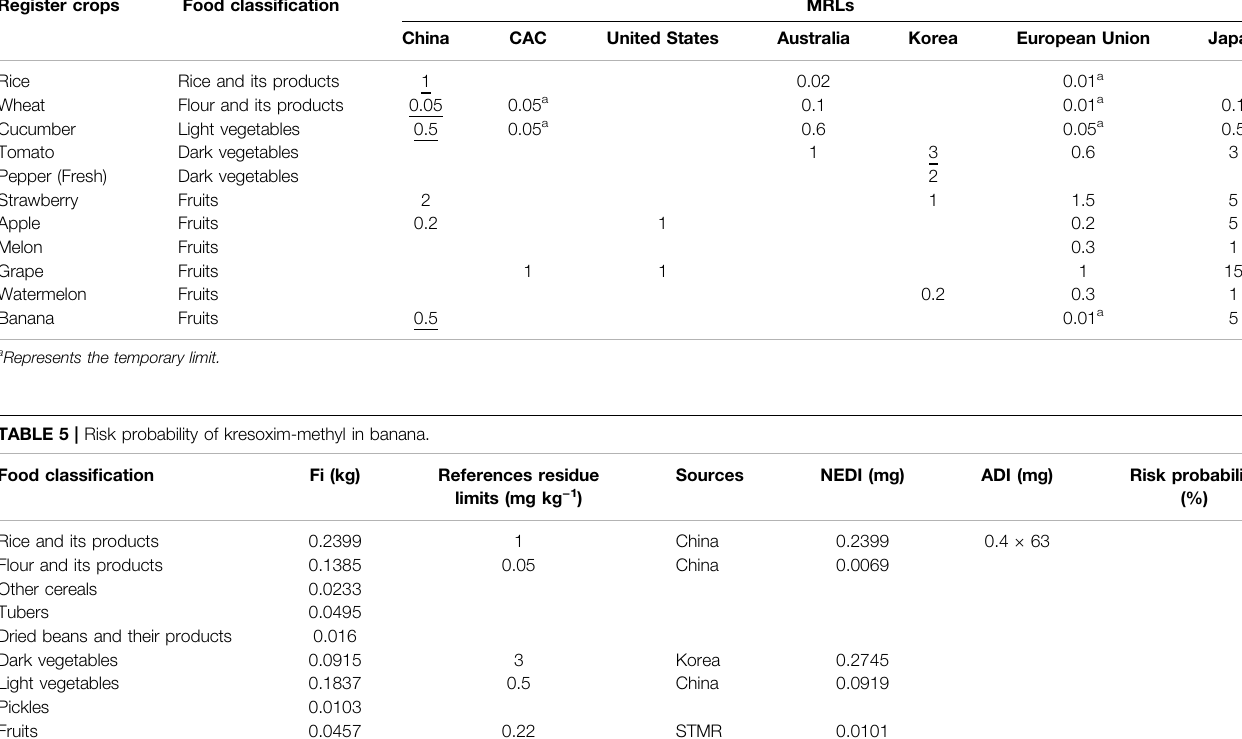
TABLE 4 | Corresponding MRLs of kresoxim-methyl registered by various countries and organizations. Register crops